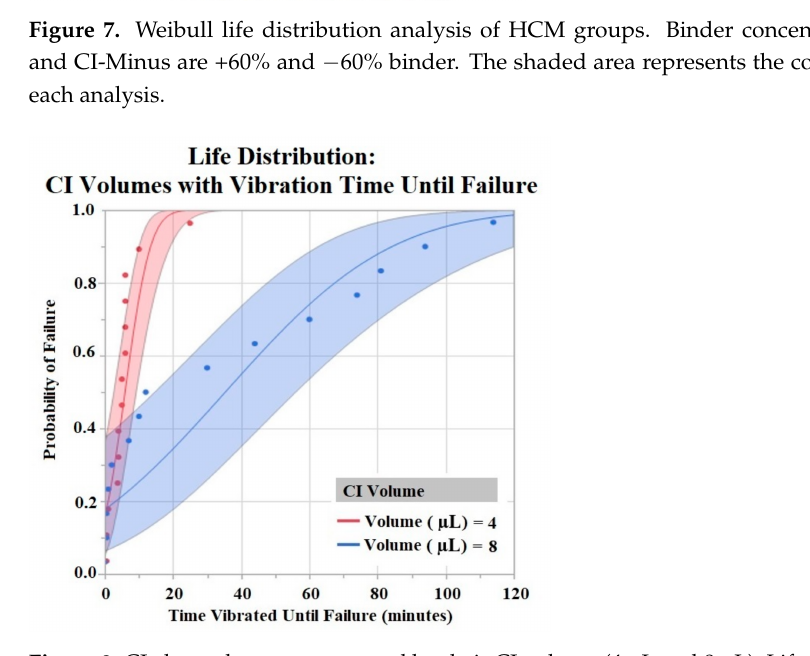
Figure 8. CI electrodes were separated by their CI volume (4 µ L and 8 µ L). Life distribution analysis produced a probability of failure model. Binder concentrations for CI-Plus and CI-Minus are +60% and − 60% binder. Confidence intervals represented by shaded area. α =